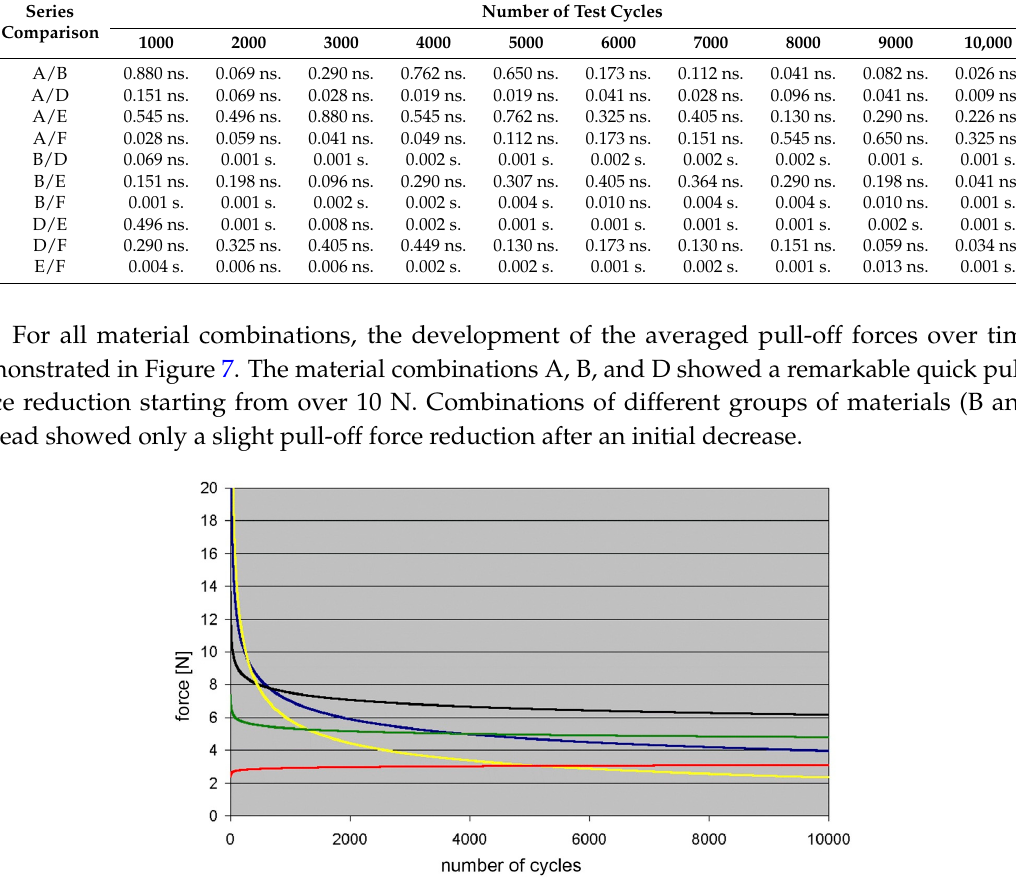
Figure 7. Comparative portrayal of the averaged sequences of pull ‐ off forces for the series: A—blue; B—black; D—yellow; E—green; F—red.